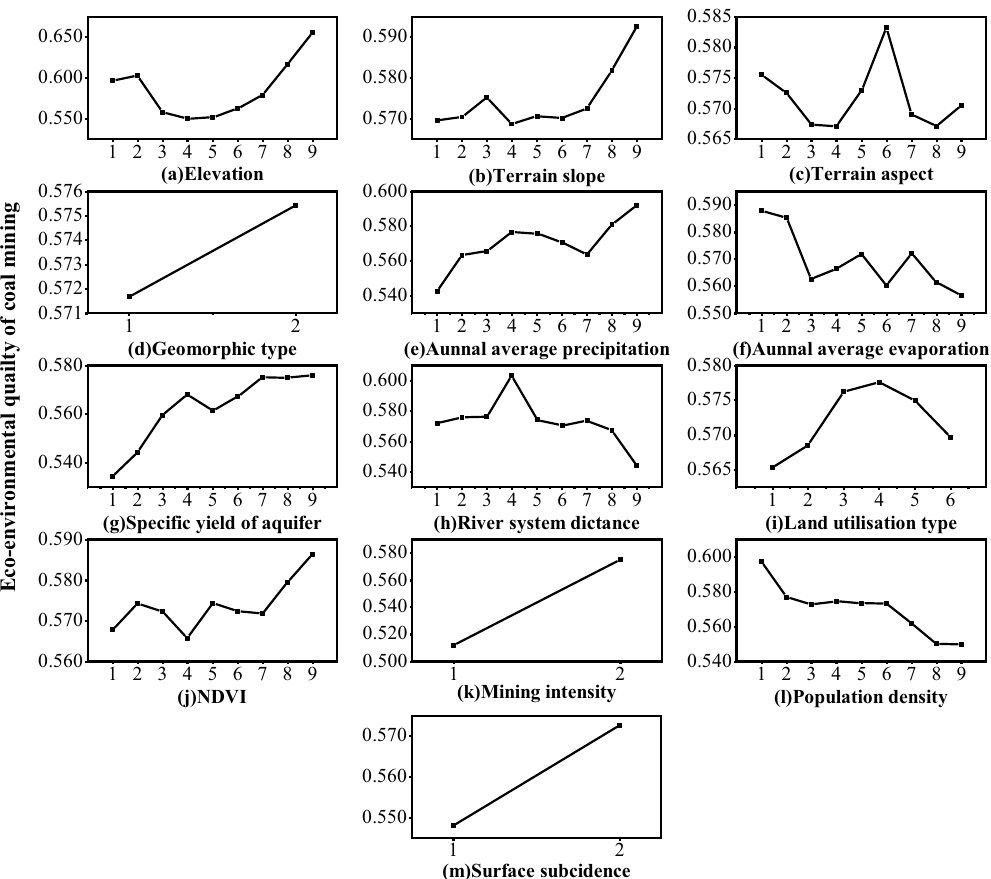
Figure 11. Change of mining area eco-environmental quality with indicator